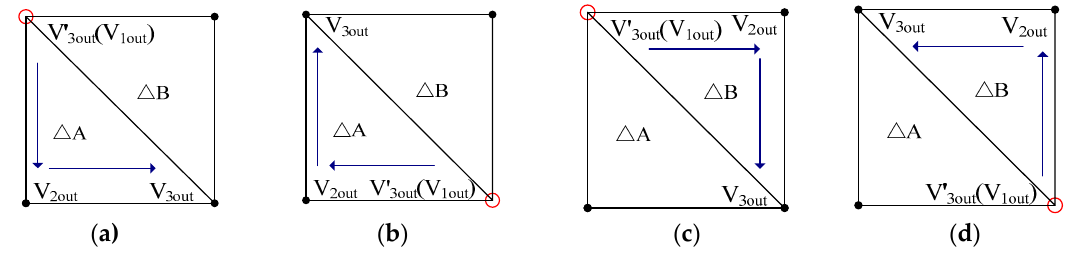
Figure 8. Switching paths in the third kind of quadrangle, ( a ) state 1; ( b ) state 2; ( c ) state 3; ( d ) state 4.